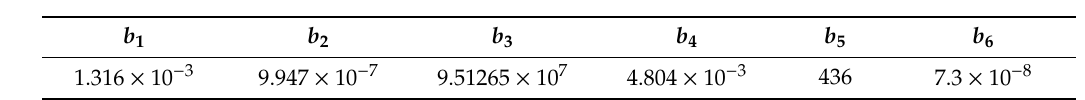
Table 4. Parameters for the Tait